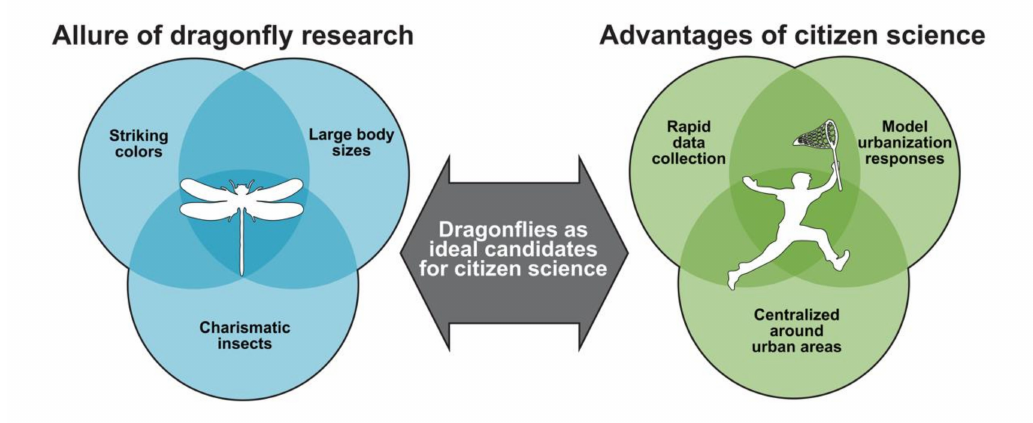
Figure 4. Dragonflies are useful as bioindicators and have high public appeal. Public involvement is key to addressing the conservation needs of dragonflies and other co-occurring insects in urban